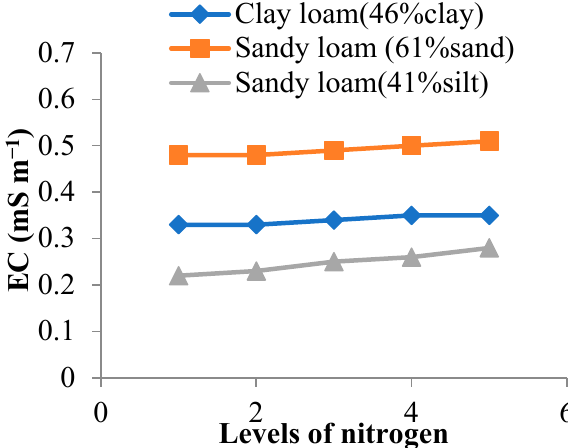
The EC of three different types of soils ranging from sandy loam to clay loam revealed an increasing trend with the level of N gradually increasing from 50–200 kg ha − 1 (Figure 2). EC was highest (0.51 mS m − 1 ) for sandy loam (61% sand) and lowest (0.22 mS m − 1 ) for sandy loam (41% silt) soil, as demonstrated in Figure 2. For clay loam, the increase in EC was 6.1% when the N level was increased from 50 kg ha − 1 to 200 kg ha − 1 . For sandy loam (61% sand), the EC increased by 6.2% with an increase in N level from 50 kg ha − 1 to 200 kg ha − 1 , while for sandy loam (41% silt), the change in EC was the highest (21.7%) for the same change in N level. Thus, the influence of N on EC was found to be the highest in soil with the maximum silt percentage.